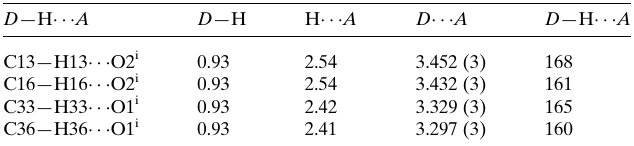
Table 1 Hydrogen-bond geometry (A˚ , (cid:2) ).